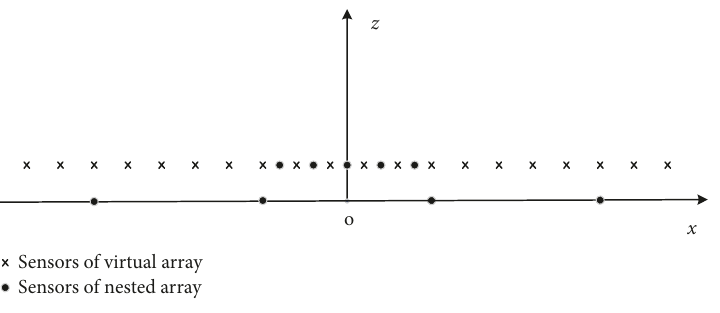
Figure 2: Virtual array formed by the nested